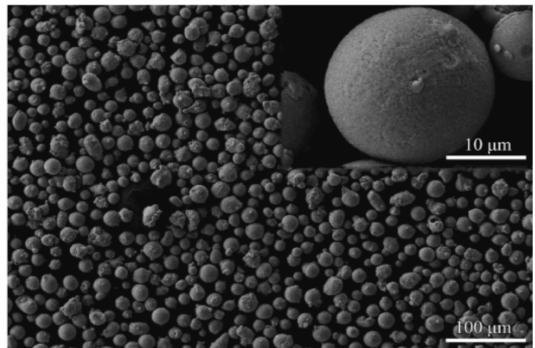
Figure 1. The microstructure of the NiCrAlY powder used for high-velocity oxygen fuel spraying (HVOF)